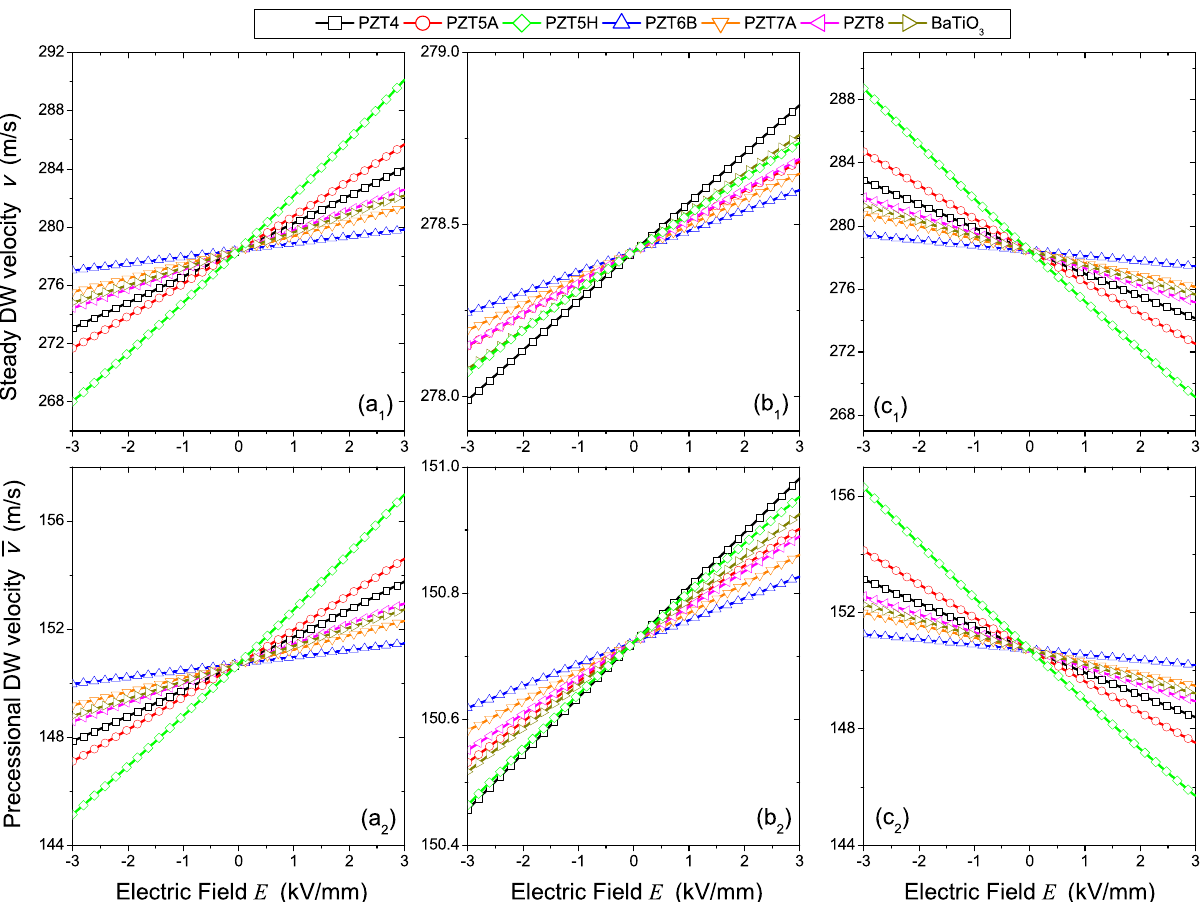
Figure 3. Electric-field dependence of steady (top panels) and precessional (bottom panels) velocity in the three proposed configurations, ( a 1 , a 2 ) E// Π //e x , ( b 1 , b 2 ) E// Π //e y and ( c 1 , c 2 ) E// Π //e z , for the seven ceramic PZ materials taken into ac- count (depicted in the top legend). Steady and precessional velocities are obtained by fixing the bias magnetic field at h ext = 16.5 × 10 − 2 and h ext = 20 × 10 − 2 , respectively. These values fulfill the restrictions reported in the main